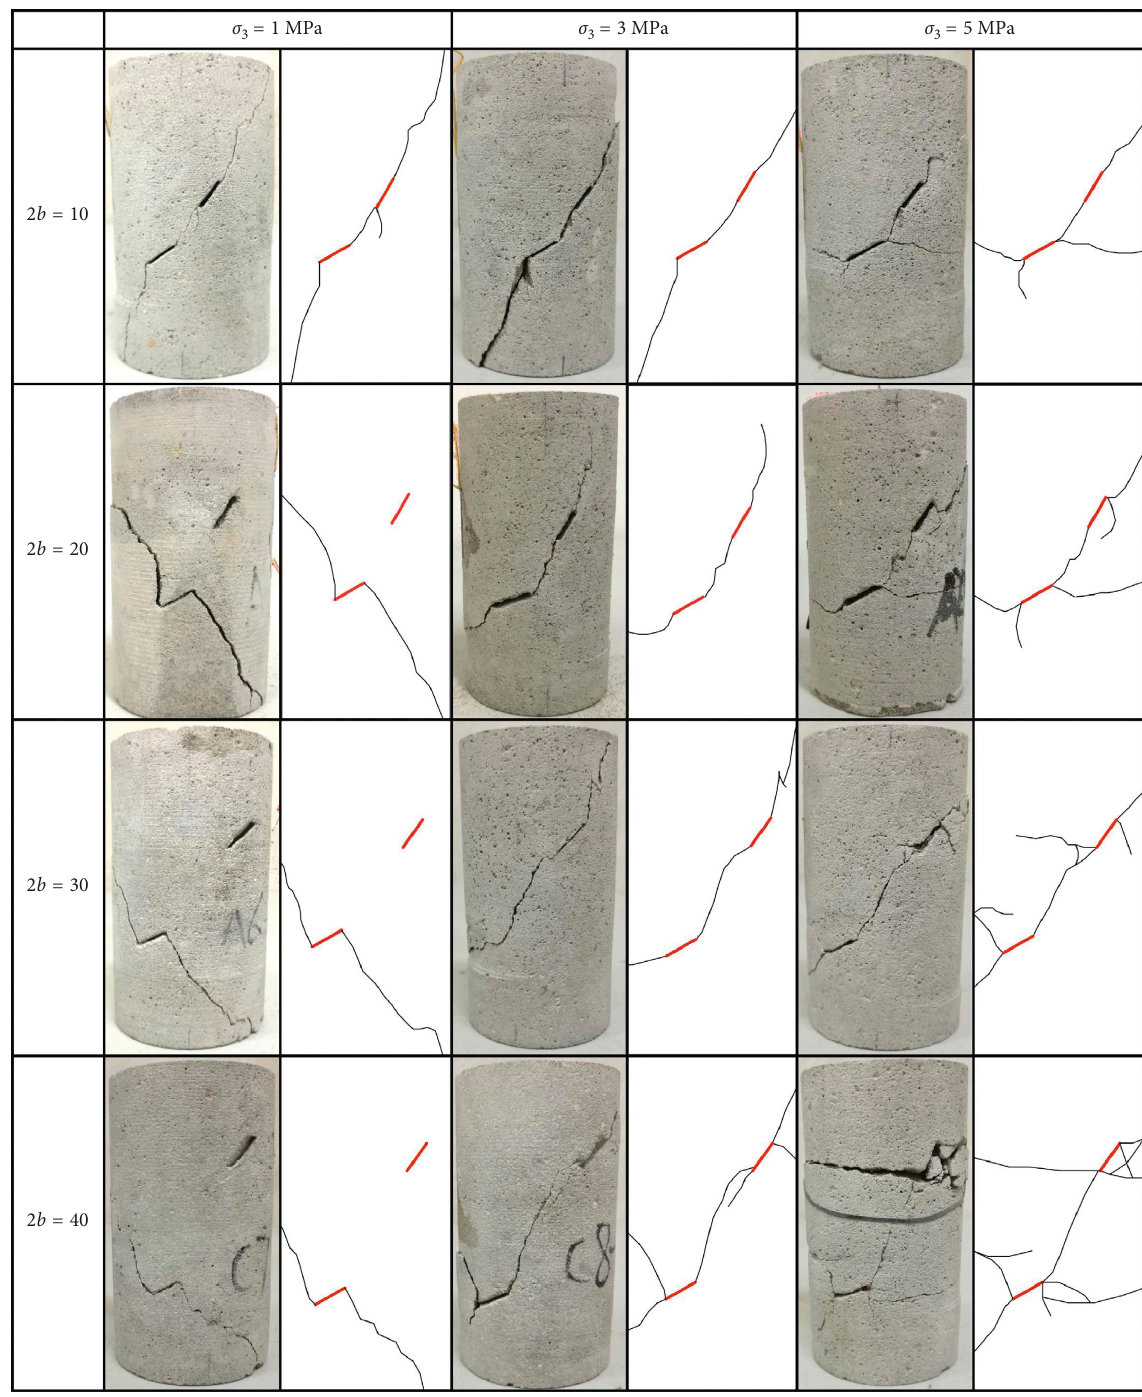
Figure 6: Failure modes of the specimens with a geometry of 2 b -30-60-60 but with different bridge